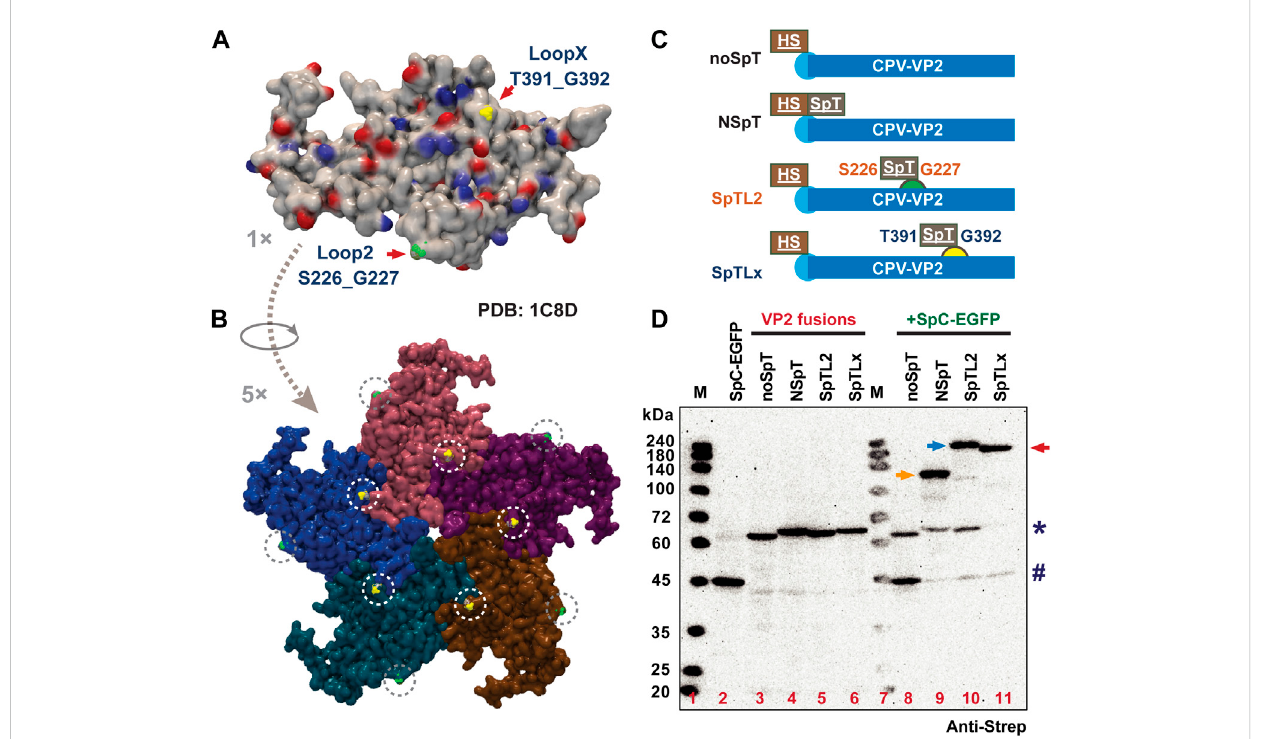
FIGURE 2 Rational design of SpT exposure site on VP2 structural protein-derived VLPs. The structure of a VP2 protein monomer (A) and partial assembly (B) were demonstrated (PDB: 4QYK). The two simulated loop regions, S226_G227 and T391_G392, were indicated as Loop 2 (green) and Loop X (yellow) by arrows, which are expected to present on the surface of VLP (60 per VLP). The SpT was designed to insert into different regions of VP2. The variants used in this study were summarized in (C) noSpT (No SpT was inserted), NSpT (N-terminus attached), SpTL2 (Loop 2 attached), and SpTLx (Loop X attached). The expression and binding ability between all VP2 SpT-fusions and SpC-EGFP in cultured Bm5 cells were veri fi ed by western blot (D) , anti- Strep). # and * indicate SpC-EGFP and VP2 variants, respectively. Arrows indicate possible ligated adducts upon co-infection of SpC-SpT